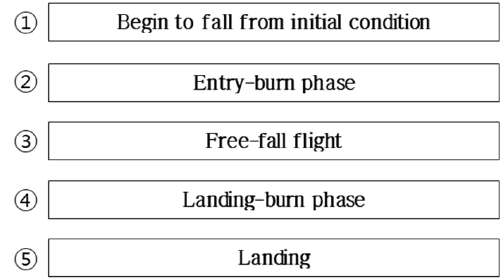
Figure 1. Basic re-entry